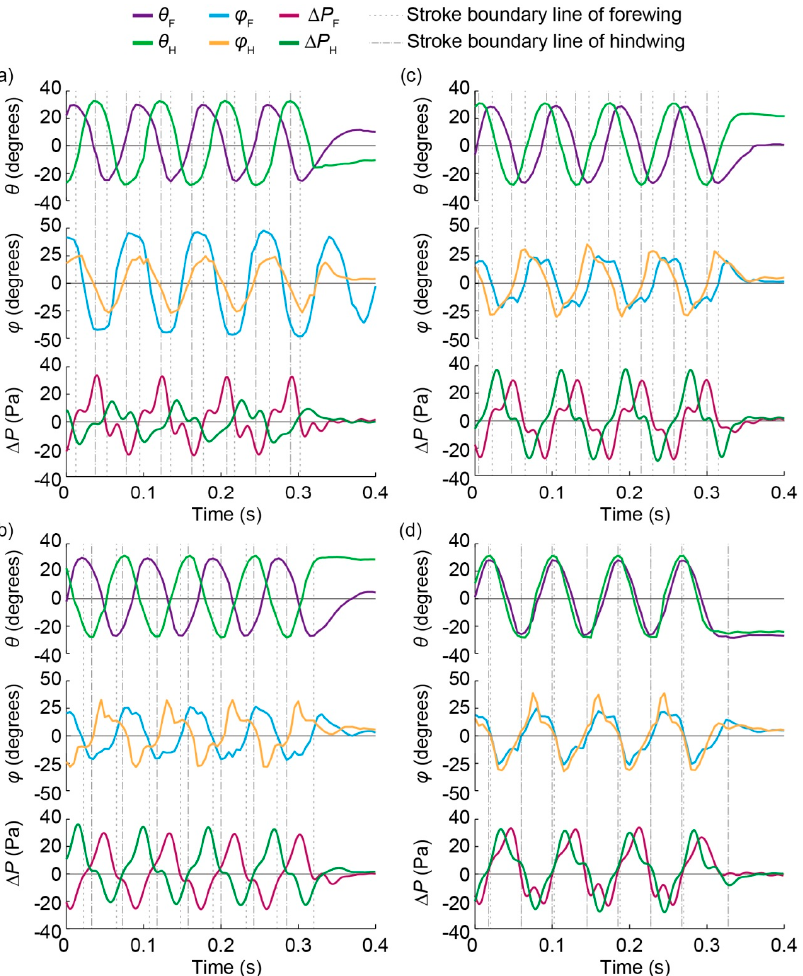
Figure 5. Flapping angle, feathering angle, and differential pressure at the four characteristic phase angles during flapping motion. The light green and blue plots present the flapping angle of the forewing and hindwing, respectively; the orange and light blue plots display the feathering angles; the green and purple plots denote the differential pressures, and the gray lines illustrate the stroke boundary lines of the forewing and hindwing. The phase angles are 116° ( a ), 215° ( b ), 285° ( c ), and 355° ( d ) for the respective graphs.